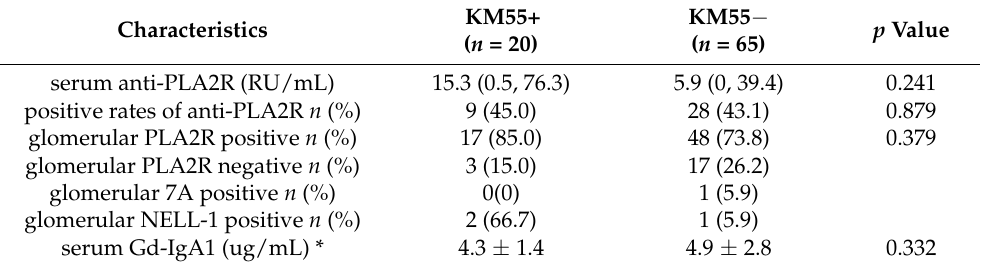
Table 6. Disease-specific pathogenic biomarkers in PMN/IgAN patients based on the staining of glomerular KM55.